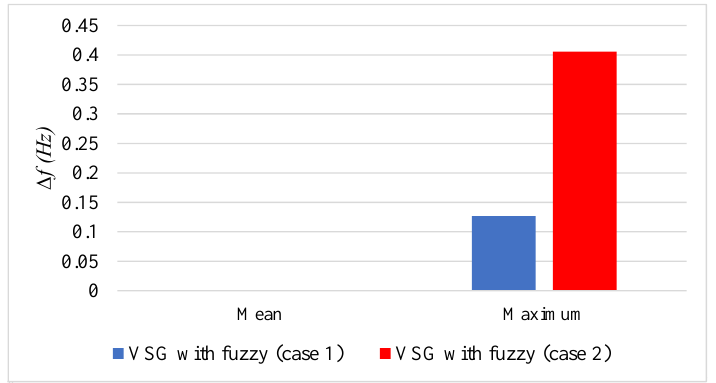
Figure 26. Microgrid frequency statistics for the scenario presented in Section 4.2.